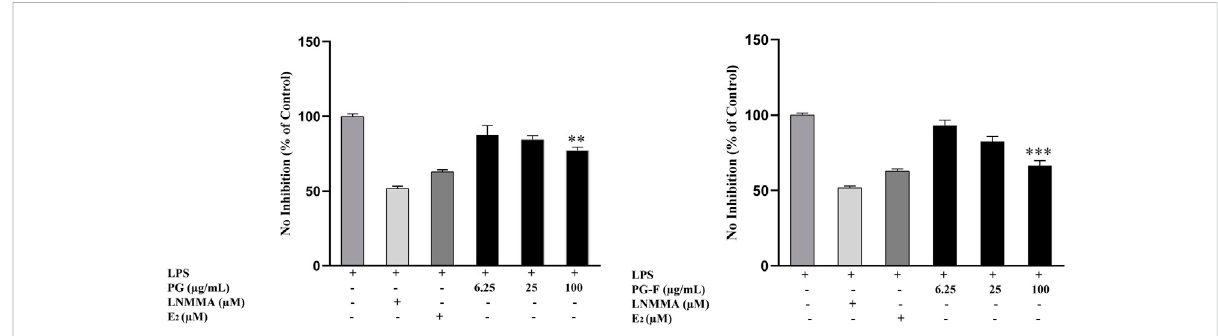
FIGURE 4 Effects of Pomegranate on the NO inhibition. RAW 264.7 cells were pretreated with Pomegranate juice for 1 h and then stimulated with LPS (1 μ g/ml) for 24 h. The concentrations of nitrite were measured as described in the materials and methods. The data shown represent the mean values of three experiments ±SD. ** p < 0.01, *** p < 0.001 as compared with the group treated with